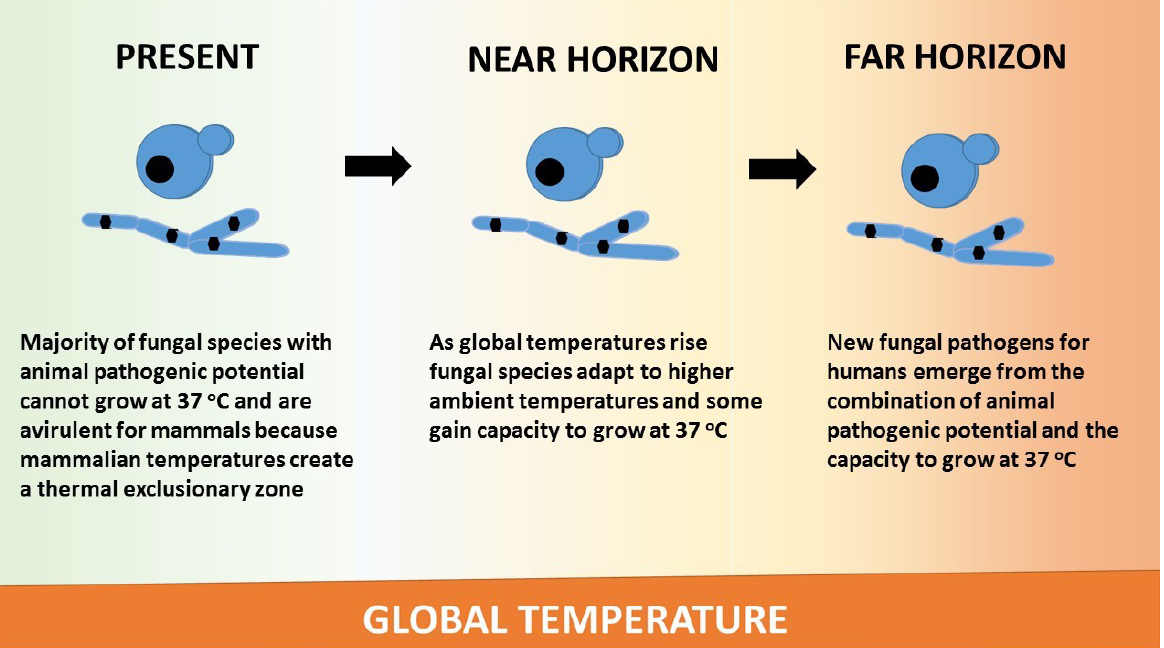
Figure 1. Global warming is hypothesized to result in the emergence of new fungal pathogens. The mechanism for this effect posits that fungi will adapt to higher temperatures by increasing their thermal tolerance. Among those species that adapt are some with pathogenic potential that are currently non- pathogenic for mammals because they cannot thrive at mammalian temperatures. However, adaptation to higher temperatures will defeat the mammalian thermal exclusionary zone, and consequently, we may encounter new fungal pathogens as the planet